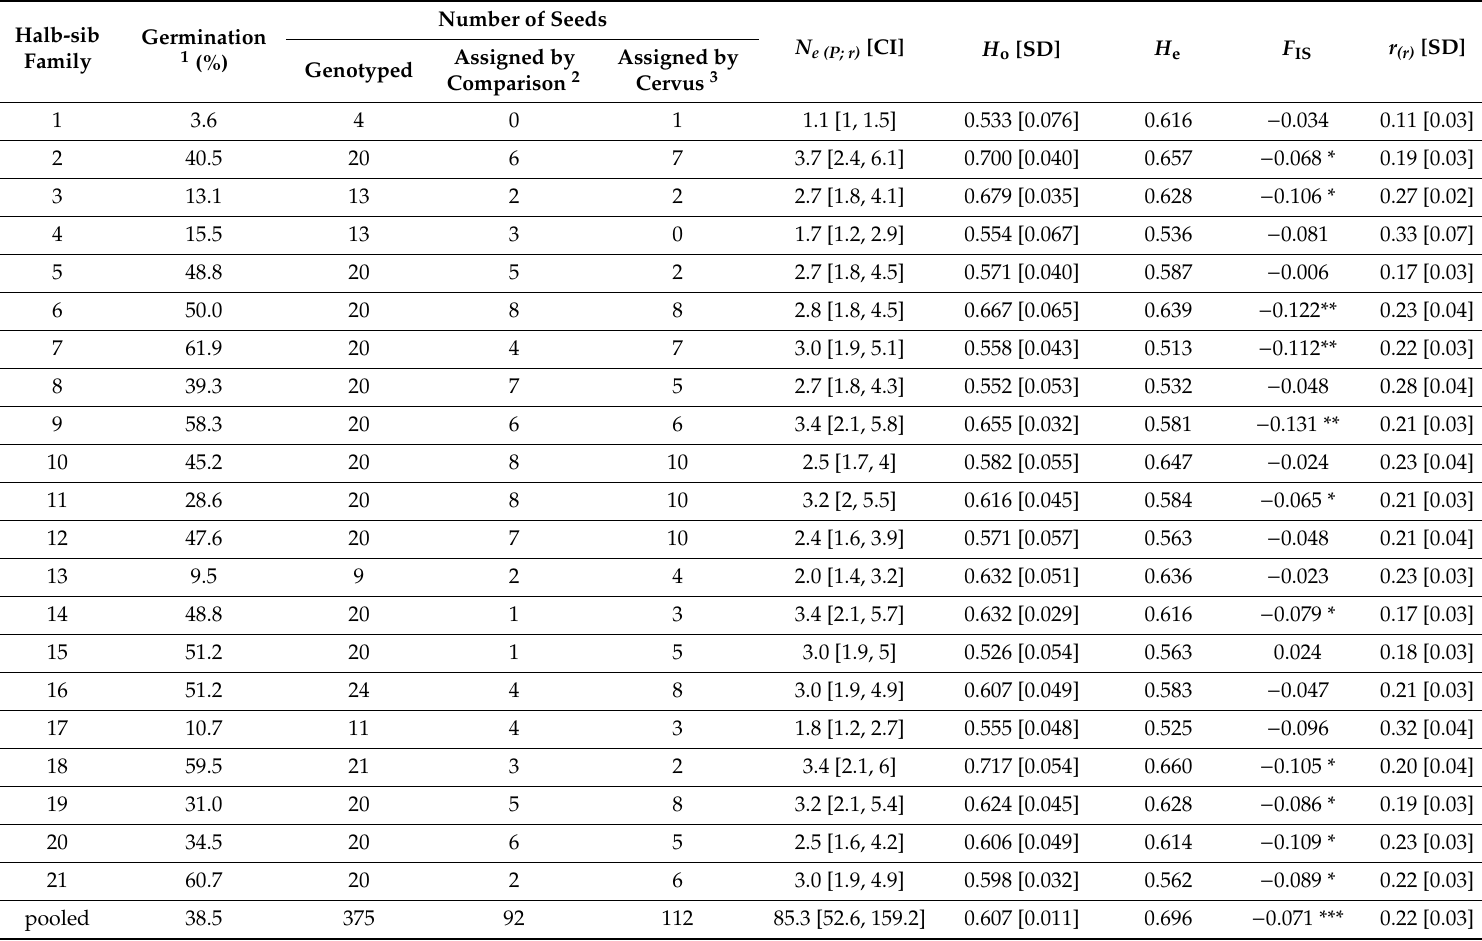
Table 1. Summary of statistical and descriptive parameters for the sampled half-sib